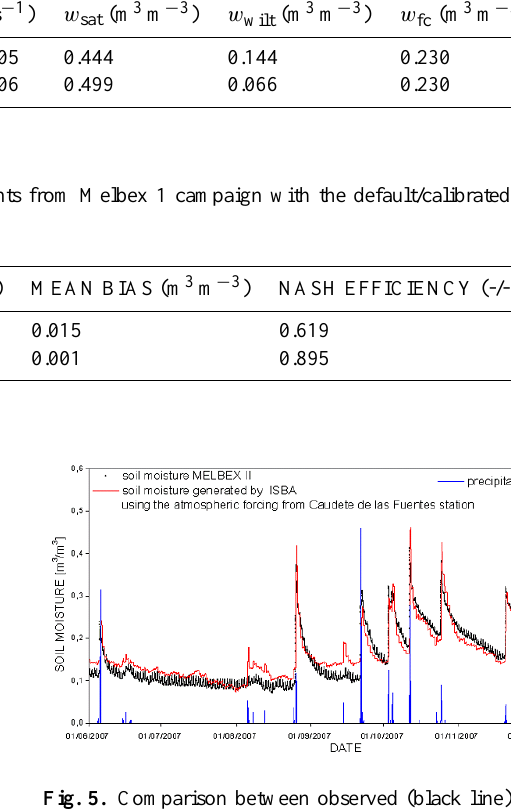
Fig. 5. Comparison between observed (black line) and simulated soil moisture using the calibrated ISBA (red line) at 5cm depth. The precipitation corresponding to the meteorological station Caudete de las Fuentes are represented in